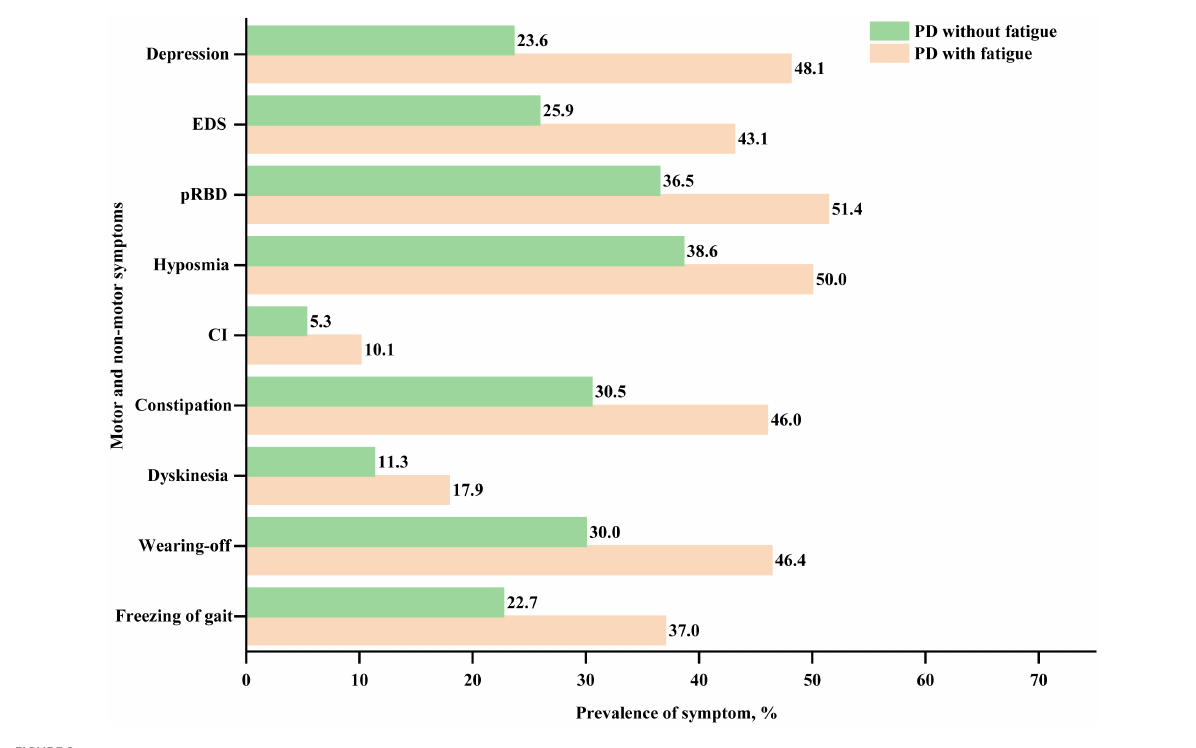
FIGURE 2 Frequency of motor and non-motor symptoms in PD with and without fatigue at baseline. PD, Parkinson’s disease; CI, cognitive impairment; pRBD, probable rapid eye movement sleep behavior disorder; and EDS, excessive daytime